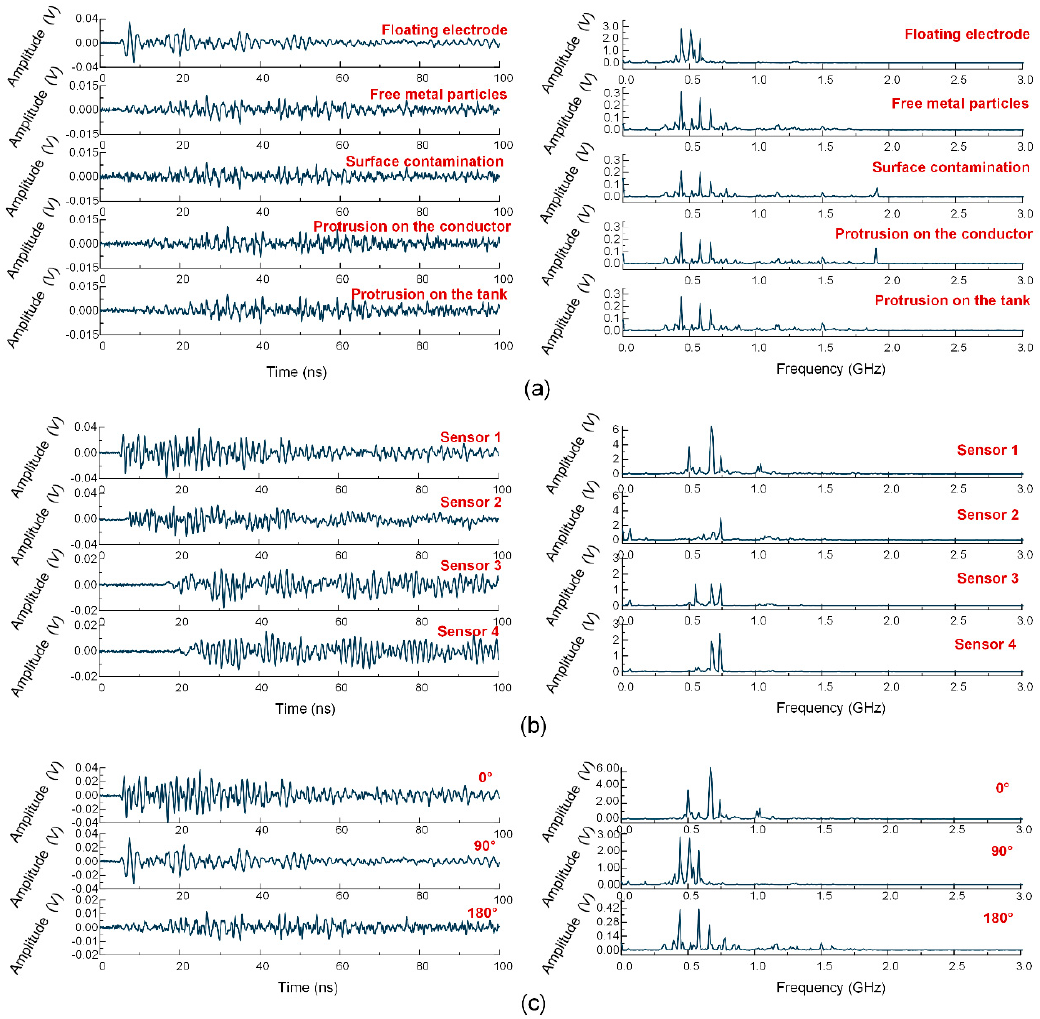
Figure 11. Typical UHF waveforms: ( a ) UHF signals of five different defect types; ( b ) UHF signals acquired from the four channels; ( c ) UHF signals of the three relative angles.